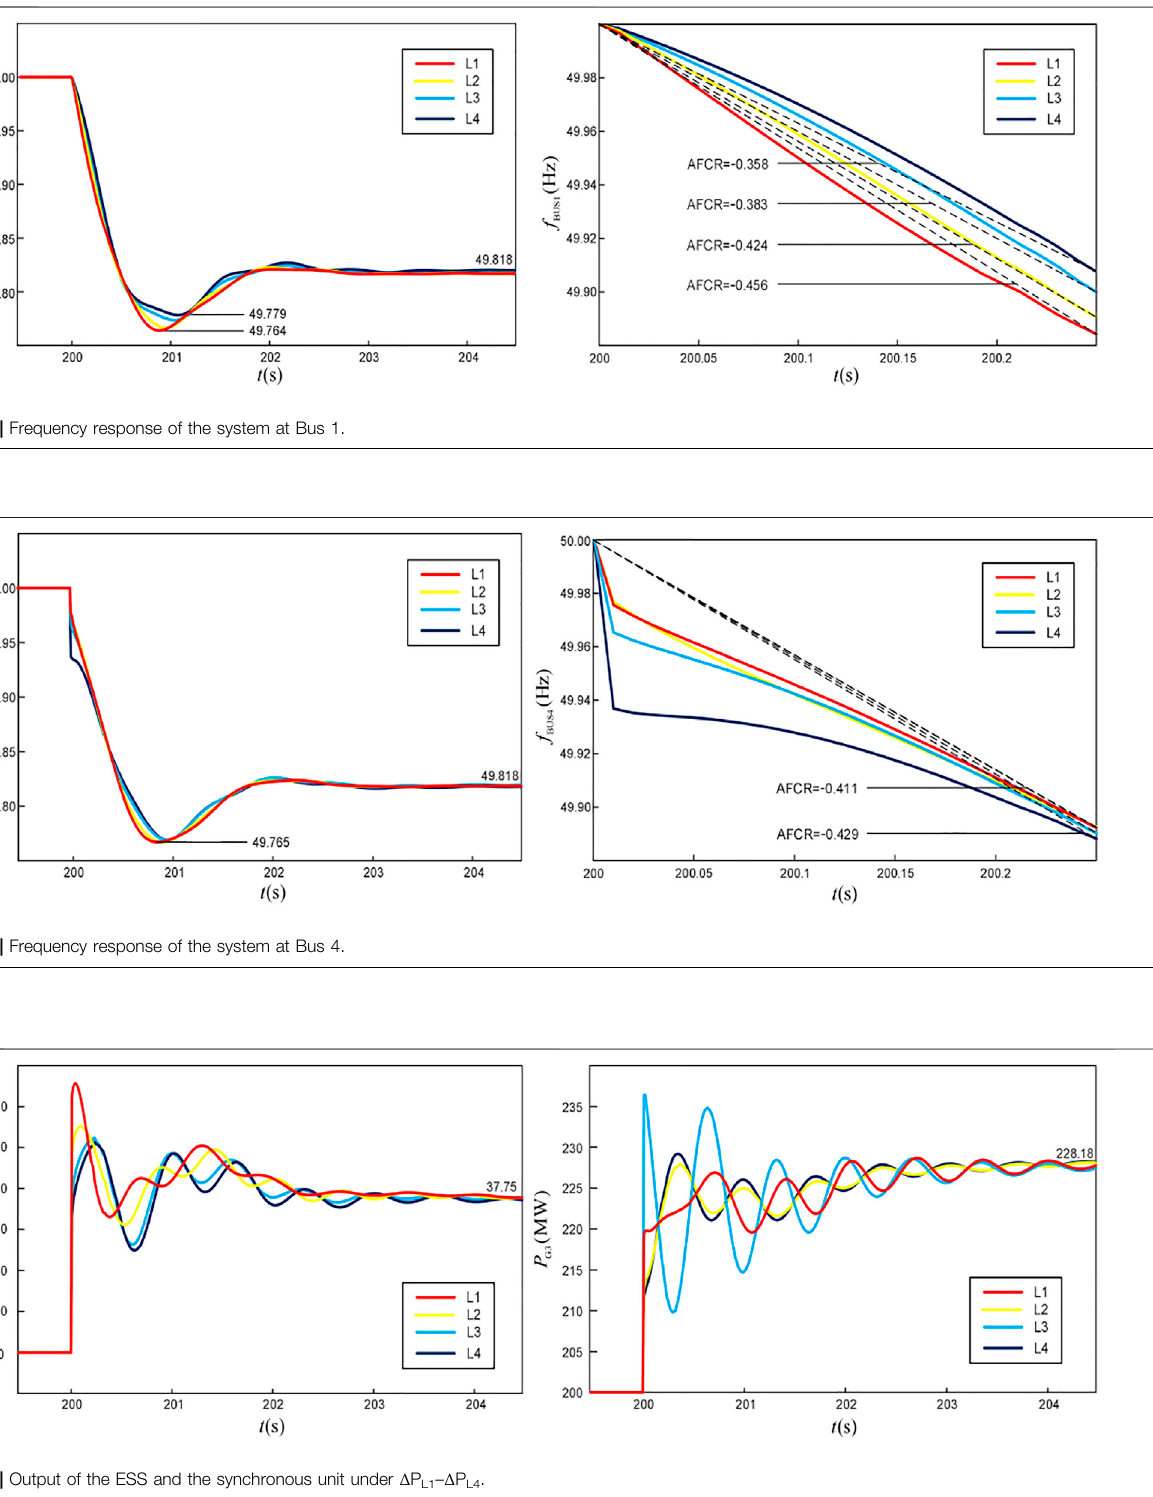
Frontiers in Energy Research |